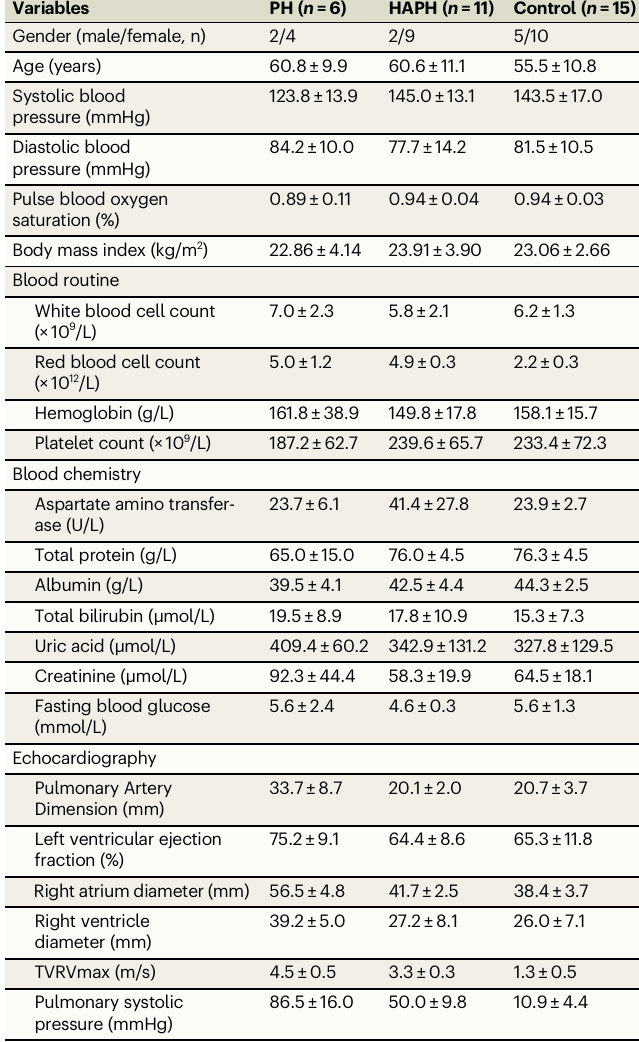
Table 1 | Characteristics of the participants in the study